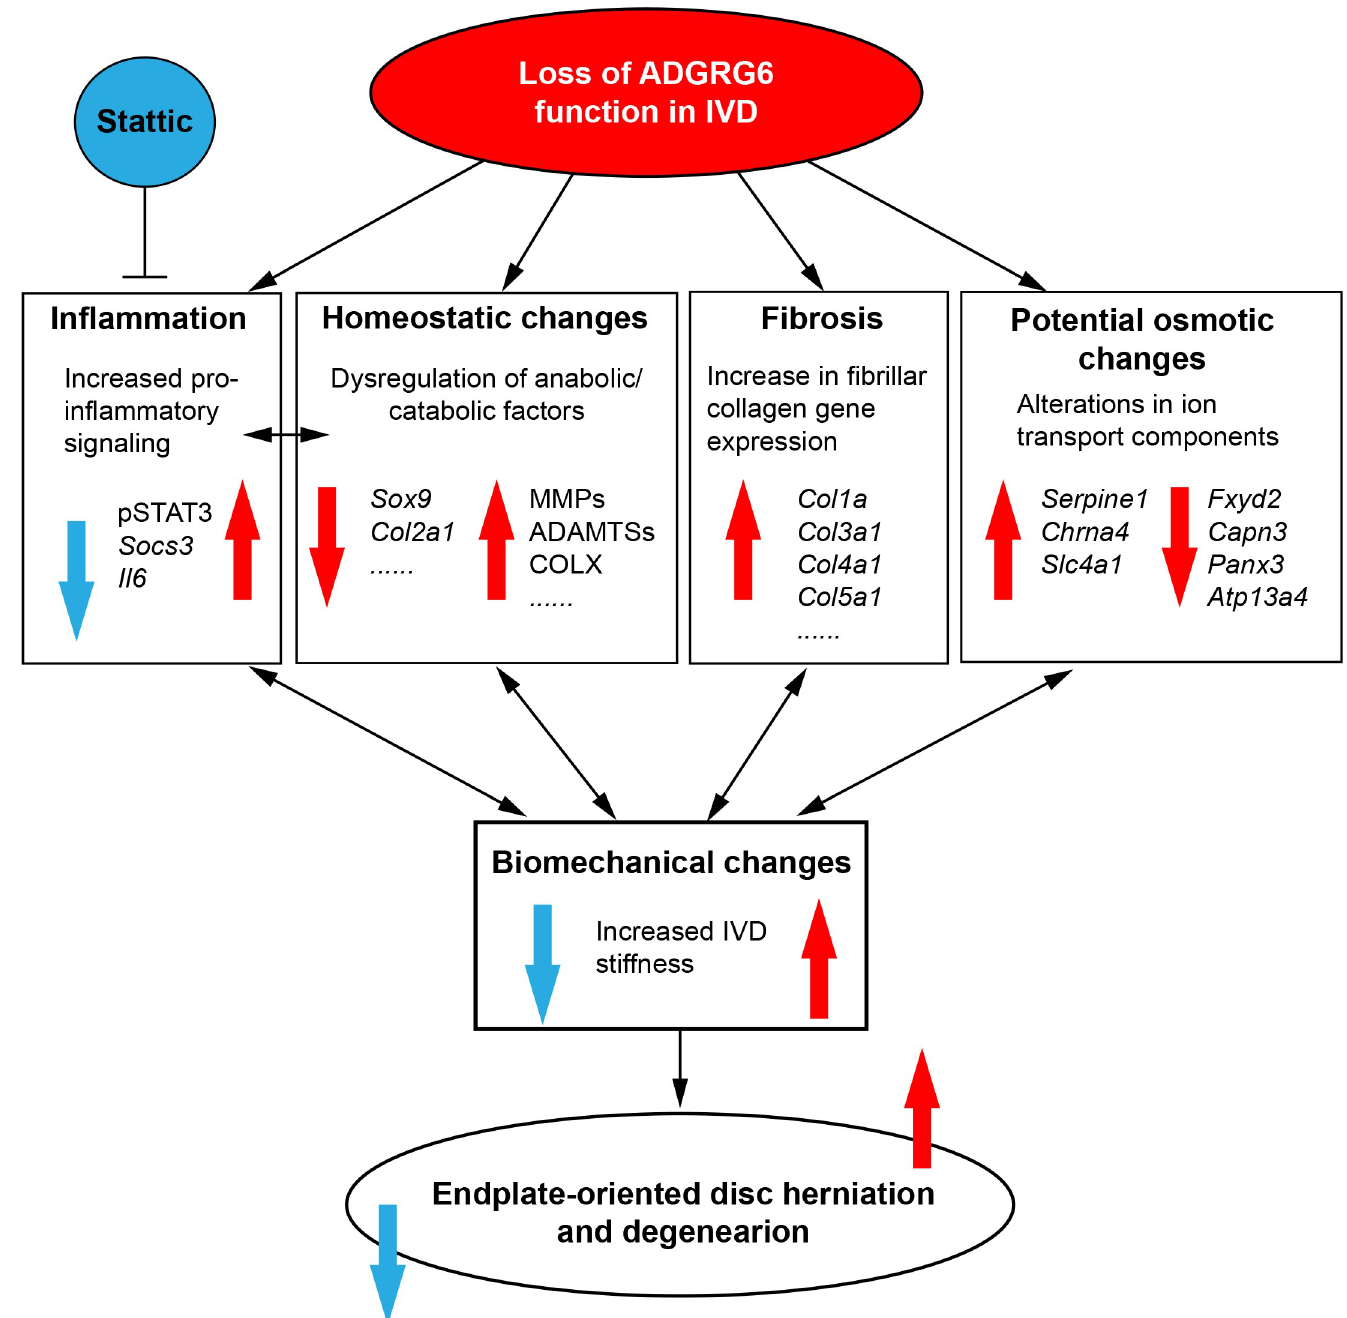
Fig 7. A model of ADGRG6 in regulating IVD integrity. Loss of ADGRG6 function in cartilaginous tissues of the IVD leads to increased pro-inflammatory singling (especially STAT3 signaling), dysregulation of anabolic and catabolic factors, fibrosis of the disc, and potential osmotic changes of the disc in young mice. These changes synergistically weaken the IVD and result in altered biomechanical changes (increased disc stiffness), and ultimately leads to endplate-oriented disc herniation in adult mice. Inhibition of STAT3 signaling by Stattic treatment can alleviates the formation of disc herniations and partially rescue the disc stiffness upon loss of ADGRG6